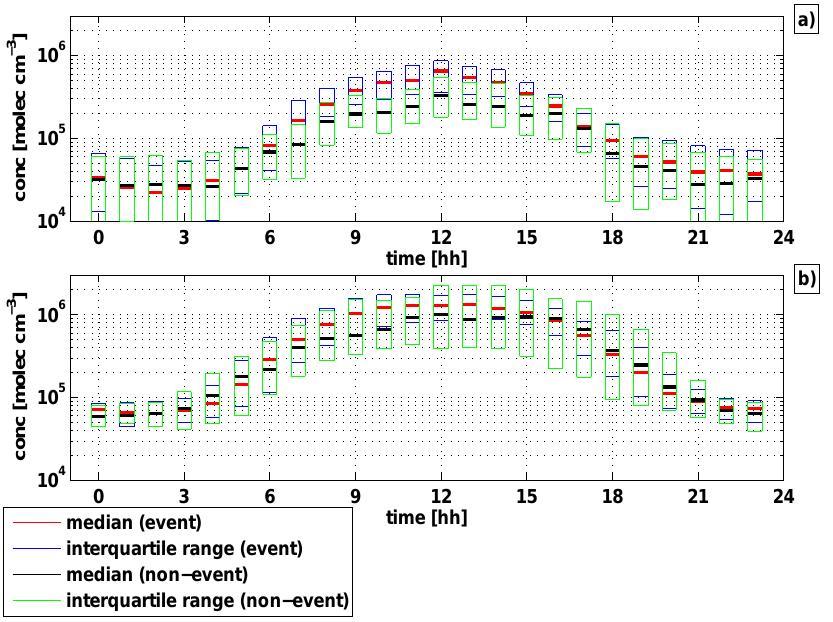
Fig. 9. Median diurnal cycle of a) measured and b) modeled hydroxyl radical concentrations during all measurement days during the EUCAARI field campaign in Hyyti¨al¨a and after grouping the days into two classes with and without new particle formation. Bar height describes interquartile range (25%-75%) of the concentrations.